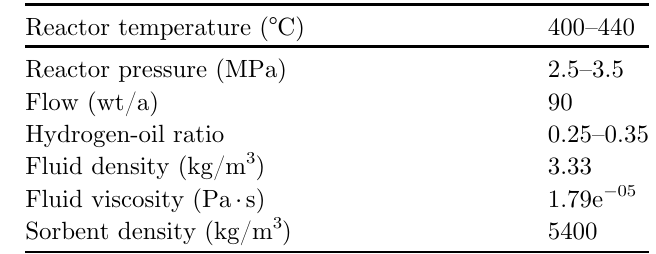
Table 1. Physical property parameters and operating conditions of medium in the reactor.